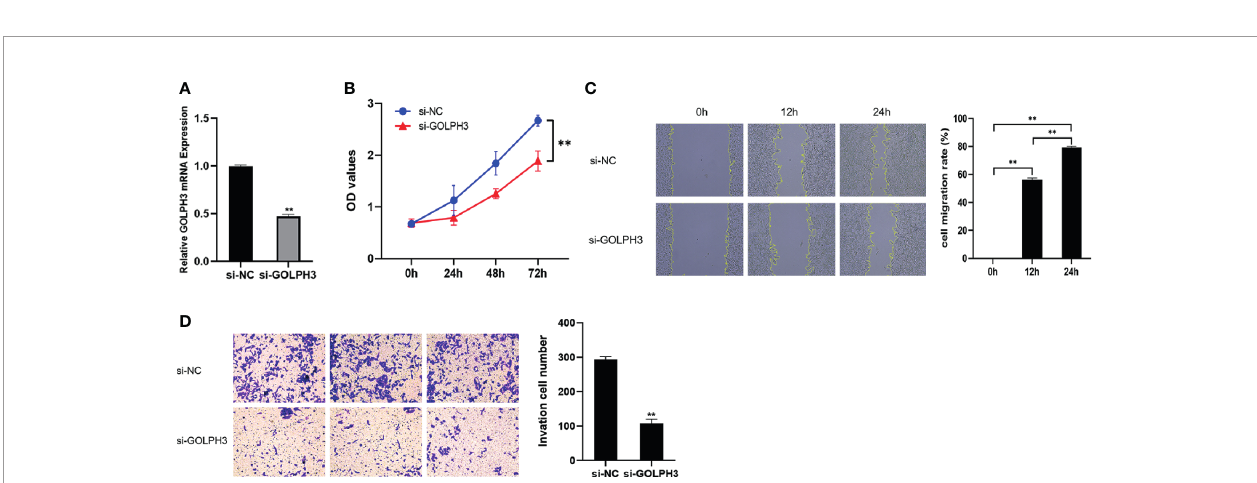
FIGURE 10 | GOLPH3 silencing suppressed A549 cell proliferation, migration, and invasion. (A) Relative GOLPH3 expression by qRT-PCR in cells transfected with si-GOLPH3. (B) CCK-8 assay was used to detect cell proliferation. (C) Wound-healing assay was used to detect cell migration. (D) Transwell assay was used to detect cell invasion. ** p <